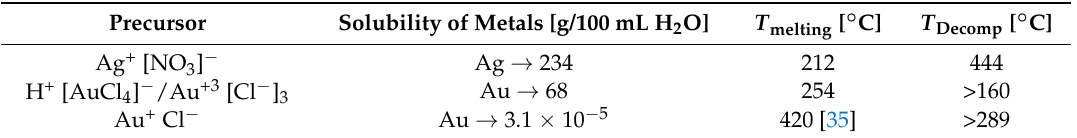
Table 1. Physical characteristics of Ag and Au precursors.